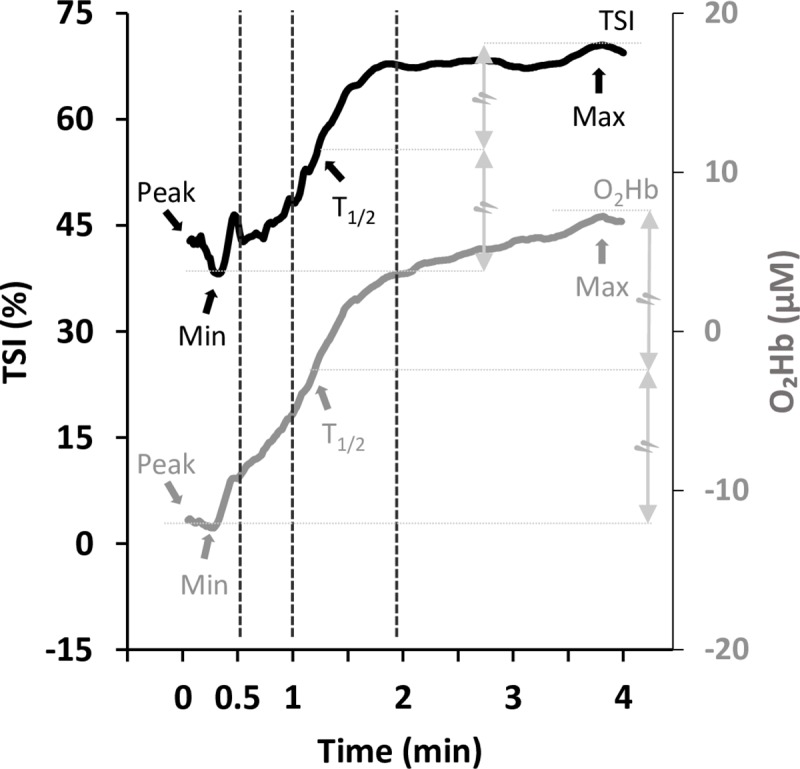
NIRS-derived tissue saturation index (TSI, black continuous trace) and oxygenated-(hemoglobin+myoglobin) (O2Hb, grey continuous trace) responses during the recovery phase of incremental (INC) exercise tests.Color-coded arrows indicate the maximum (Max) and minimum (Min) values for both parameters reached during recovery; Peak indicates the value attained at the end of the incremental test (at min zero, 0, on the x-axis).